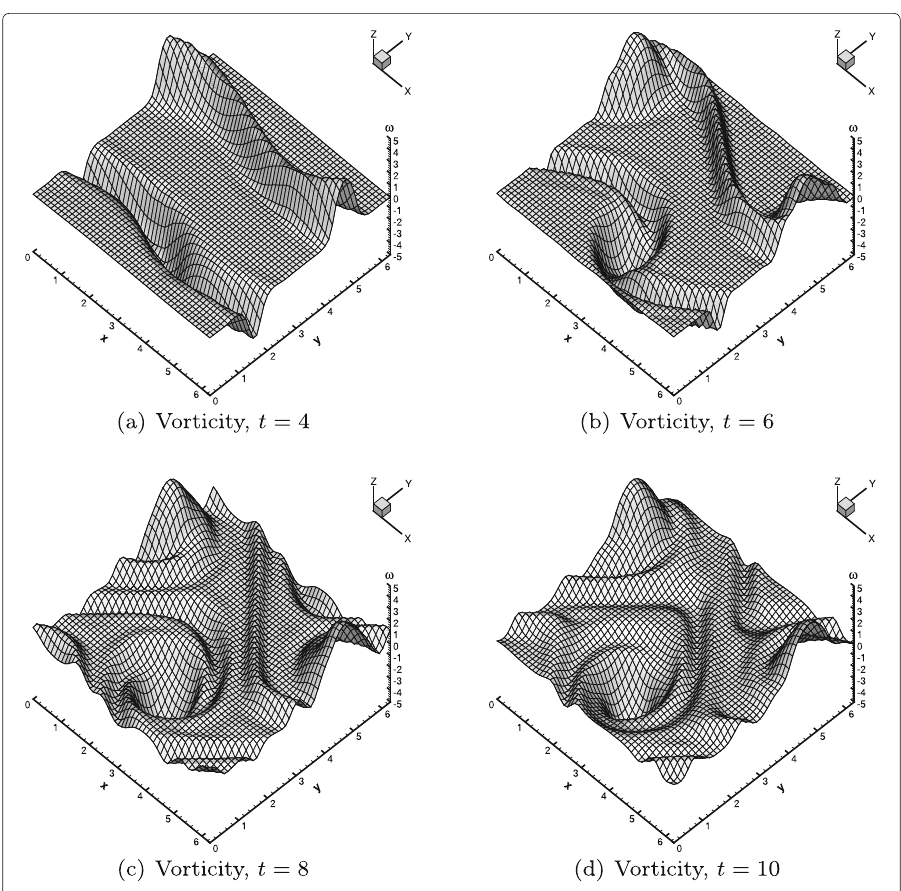
Fig. 6 Example 7. Vorticity ω = v x − u y obtained with the GSA IMEX-ARS3 WCNS on a mesh 50 × 50 at different times. a Vorticity, t = 4. b Vorticity, t = 6. c Vorticity, t = 8. d Vorticity, t = 10